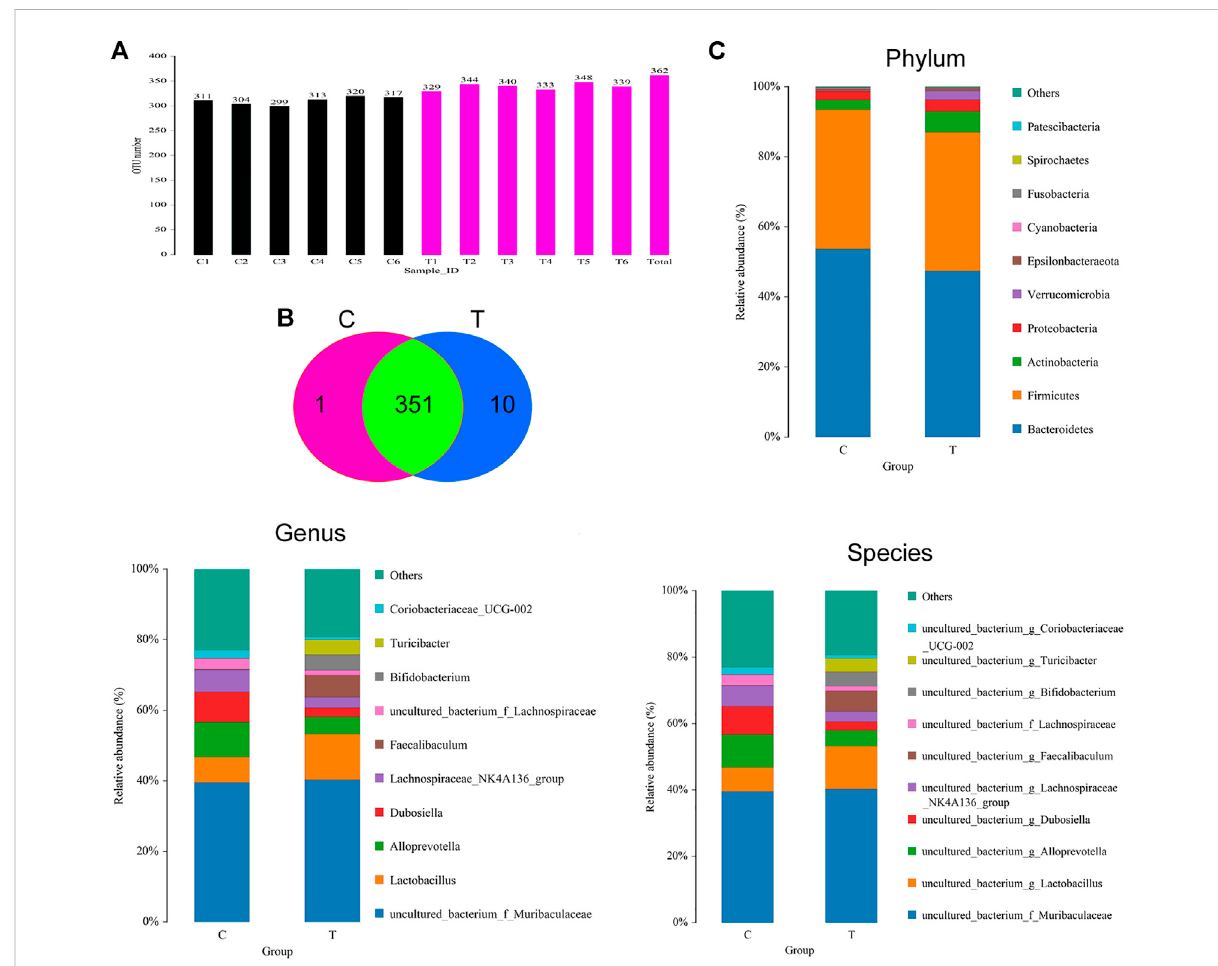
FIGURE 5 AnalysisofOTUs (A) NumberofOTUs. (B) Venndiagram;asevident,351OTUswerecommonbetweenthegroups.TheCHMACS-treatedgroup showed 10 unique OTUs, while the control group showed only one unique OTU. (C) Gut microbiota clustering and species